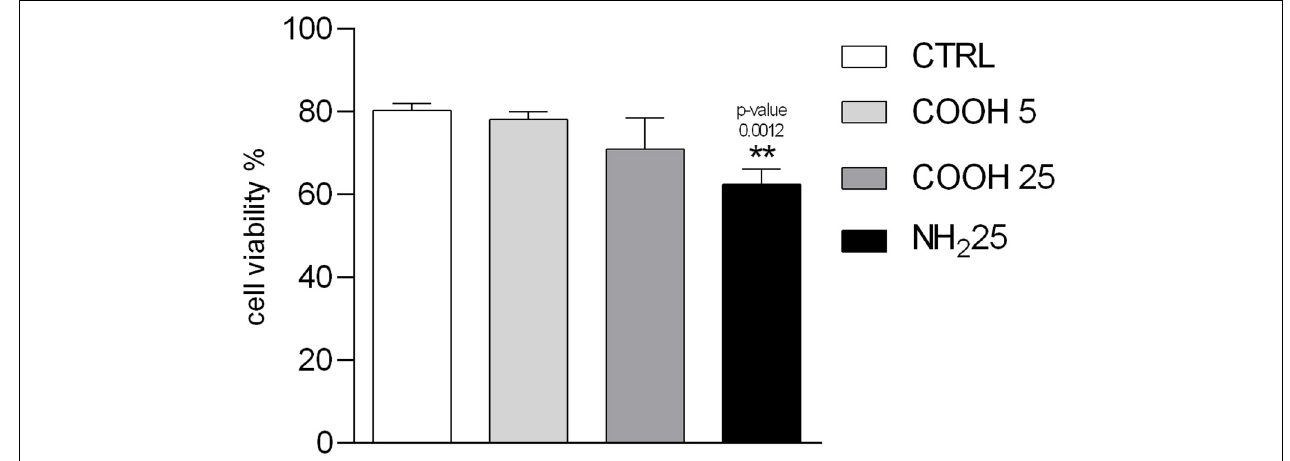
FIGURE 2 | Immune cell viability. Percentage of viable P. lividus coelomocytes vs. total number of cells screened after 4 h of exposure to CF (control), PS-COOH (5 and 25 µ g mL − 1 ) and PS-NH 2 (25 µ g mL − 1 ). Data are reported as mean ± SD ( n = 9; Kruskal–Wallis test, Dunn’s post-test, p < 0.01). ** Indicate significant differences with respect to the control group.